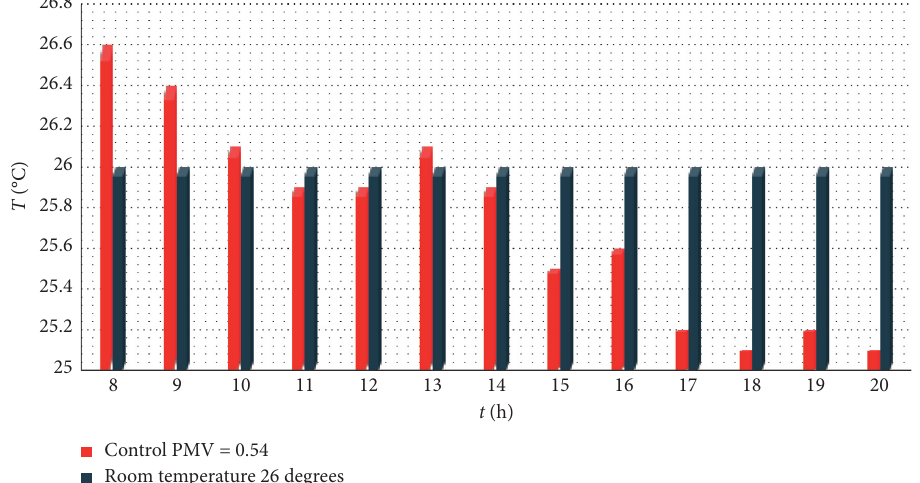
Figure 4: Variation of indoor air temperature under different control